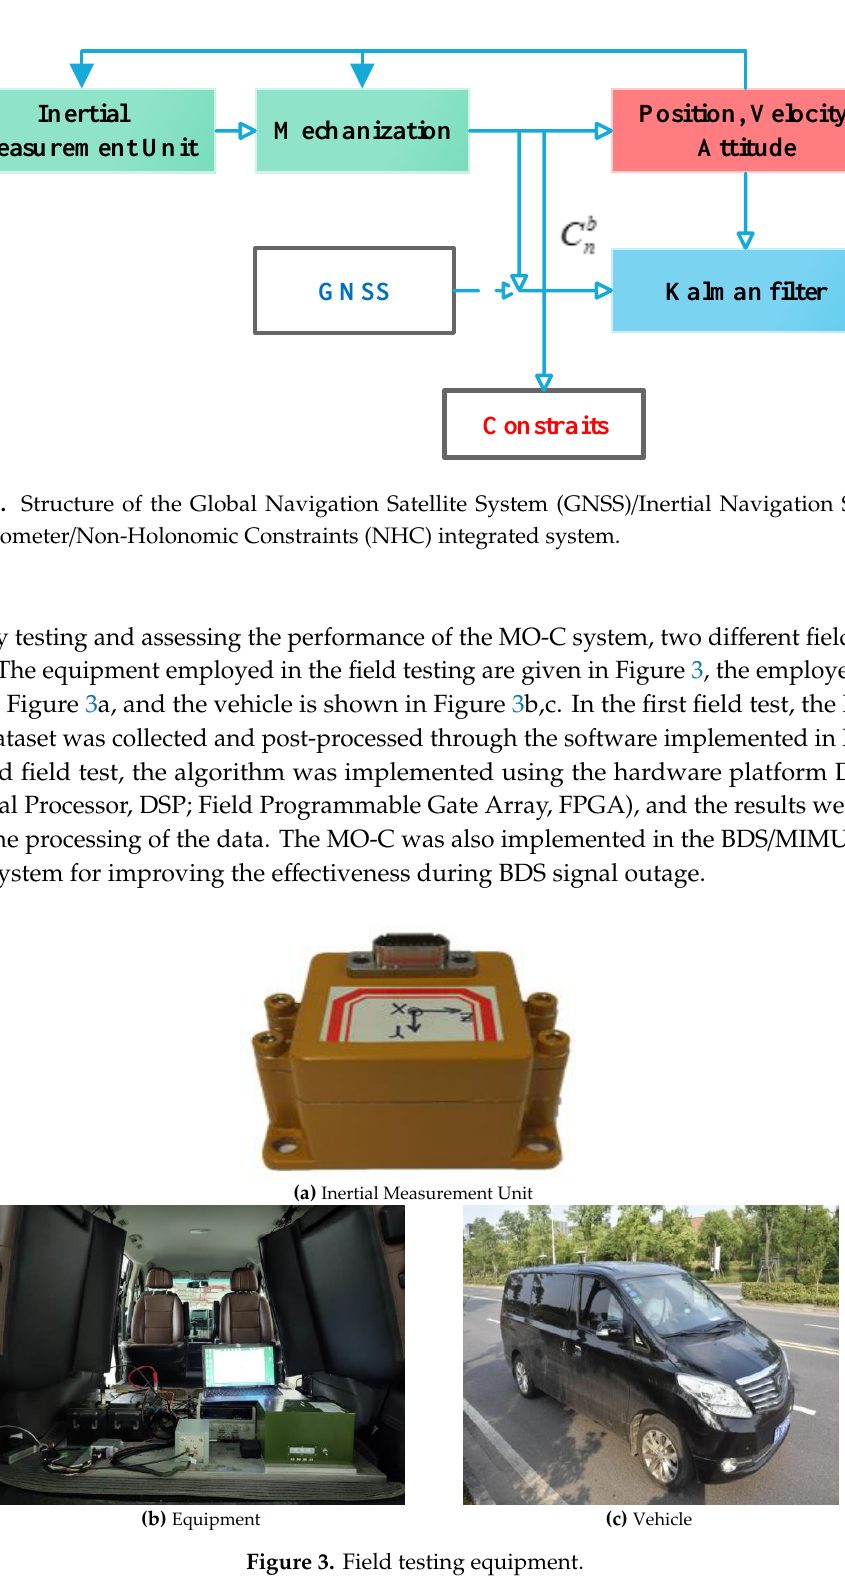
Figure 3. Field testing equipment.